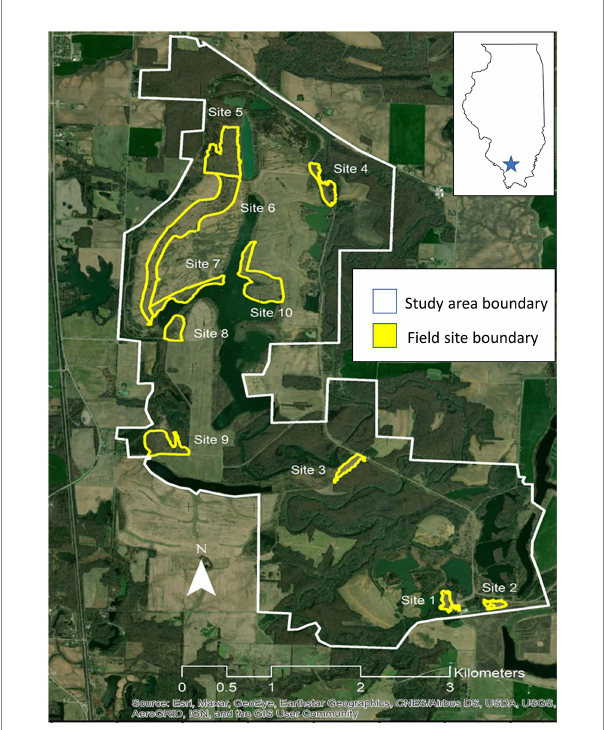
FIGURE 1 Map of Burning Star State Fish and Wildlife Area in Jackson County, IL, United States, where fieldwork for this study occurred. Inset on the top right shows the location of Burning Star in the state of